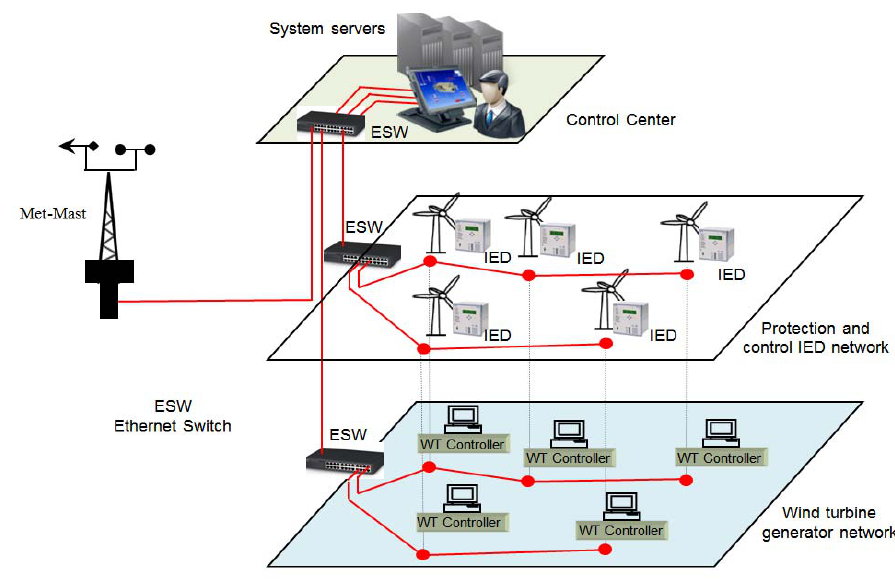
Figure 1. Conventional WPF communication